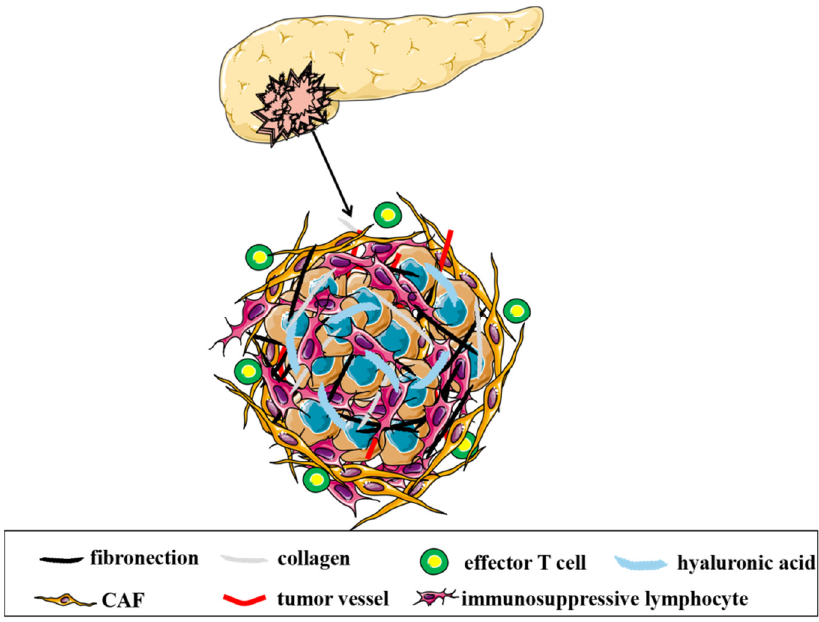
Figure 1. The tumor immune microenvironment (TIME) of PDAC.